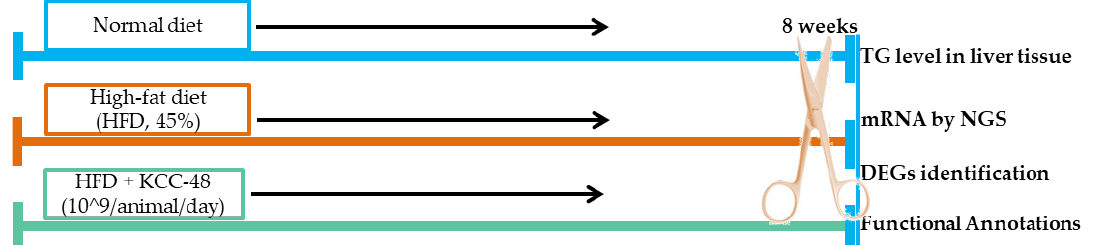
Figure 4. Experimental design and diet intervention. TG, triglycerides; NGS, Next-Generation Sequencing; DEGs, differentially expressed genes.